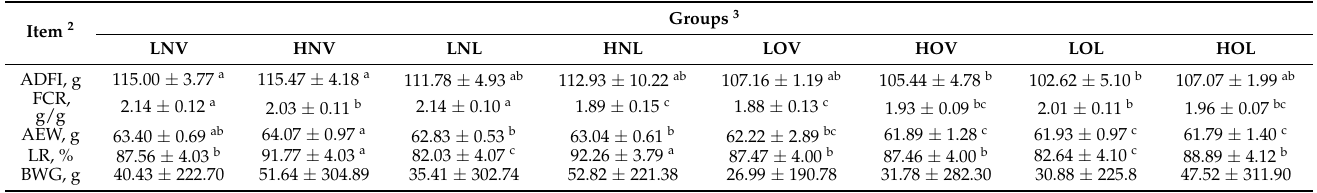
Table 3. Effect of vegetable oil and lard with different qualities and concentrations on production performance of lay- ing hens 1